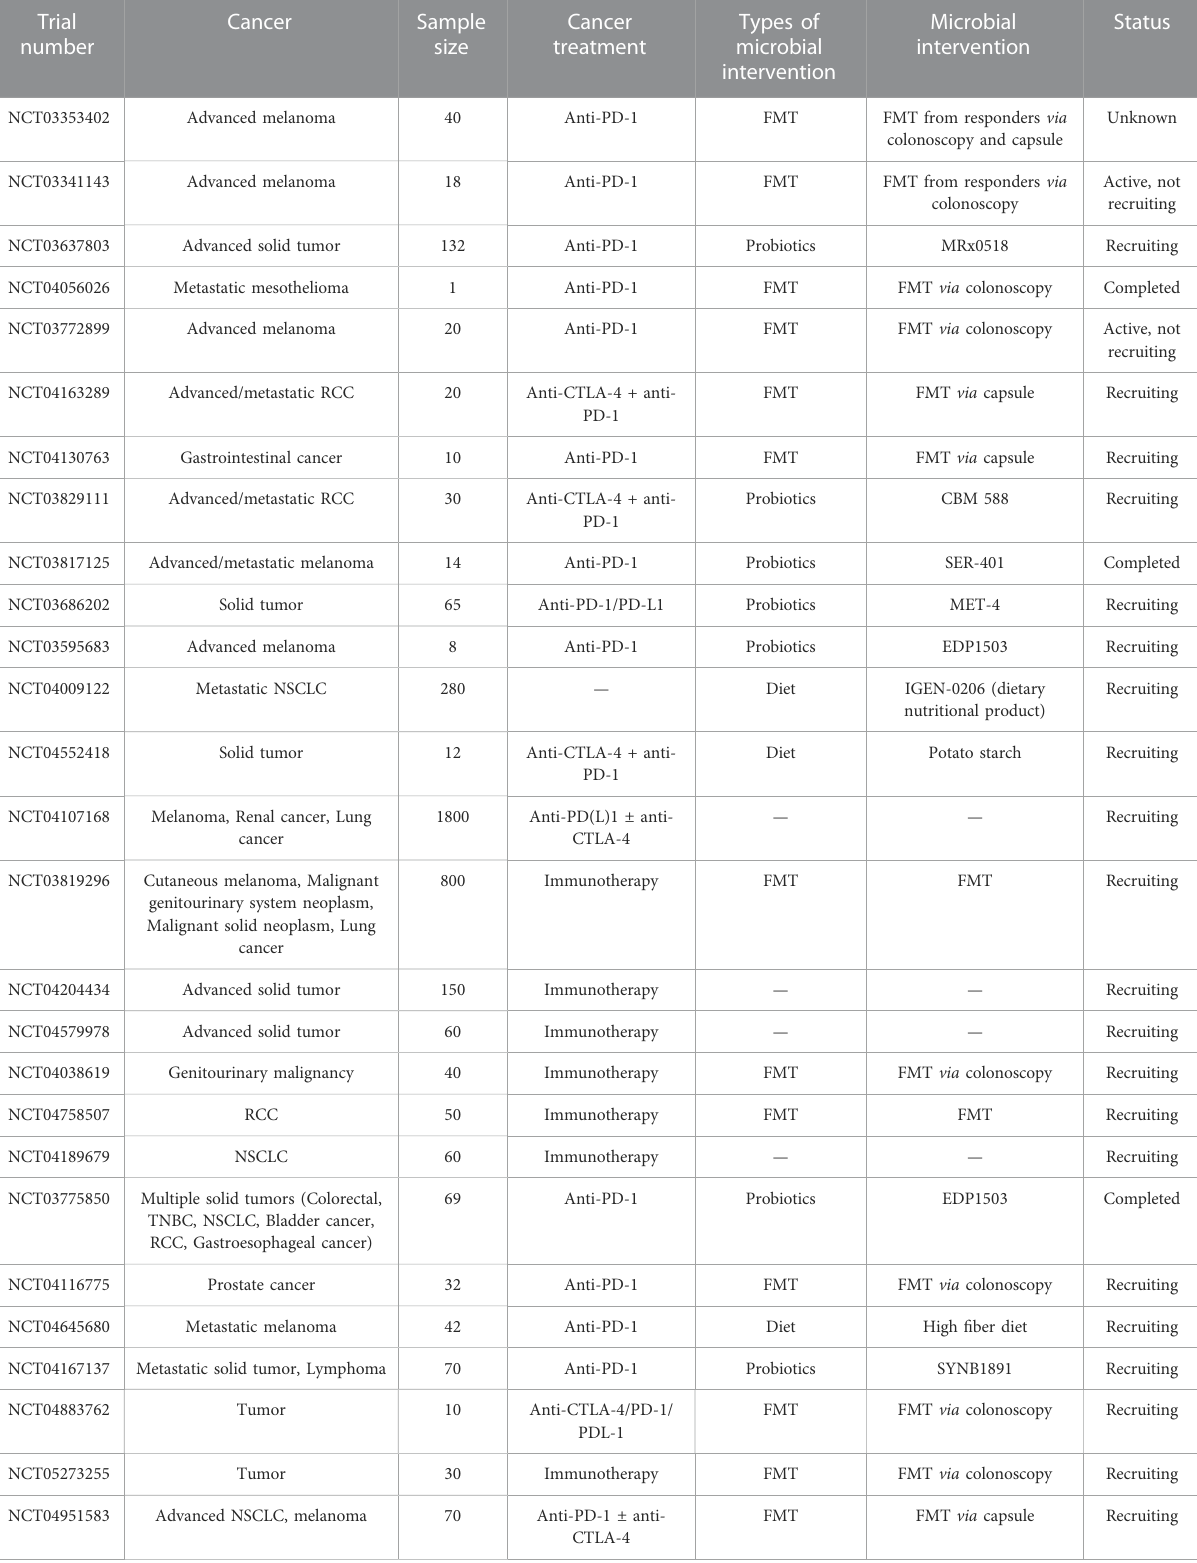
TABLE 1 Clinical evidence linking gut microbiota and cancer immunotherapy. Trial